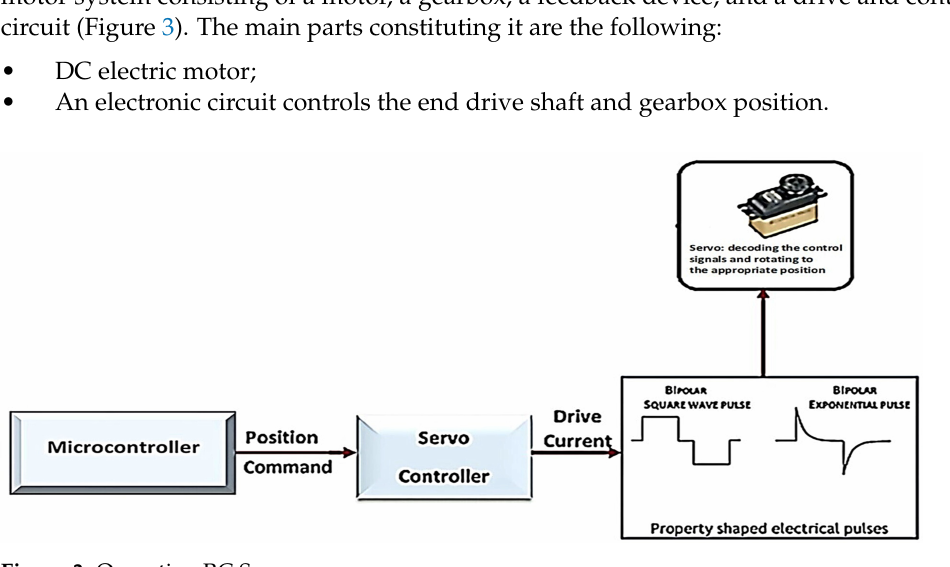
Figure 3. Operation RC